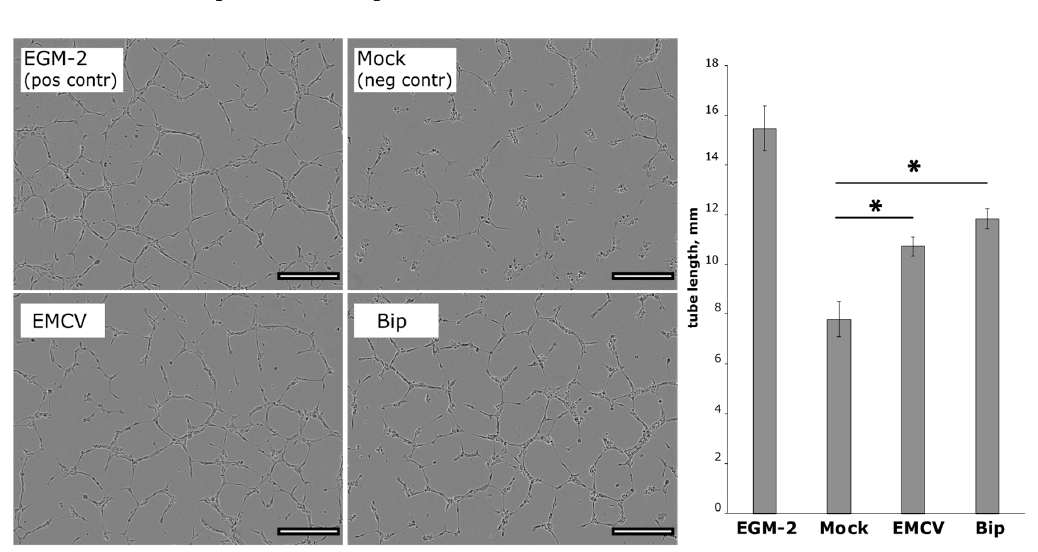
Figure 1. Designs of internal ribosome entry site (IRES)-based cytomegalovirus (CMV)-driven plasmids and results of expression activity analysis in HEK293T culture. A . IRES-based plasmid vectors to express human hepatocyte growth factor (HGF) and vascular endothelial growth factor (VEGF)165 with alternative designs: ( left ) VEGF165 gene upstream to EMCV_IRES or ( right ) HGF gene upstream to EMCV_IRES. B . Molar concentrations of HGF and VEGF165 ( left ) and their ratios ( right ) after ELISA of culture medium from transfected HEK293T cells. Data presented as mean ± SEM. Results are only from samples with both detectable angiogenic growth factors (AGFs) provided.